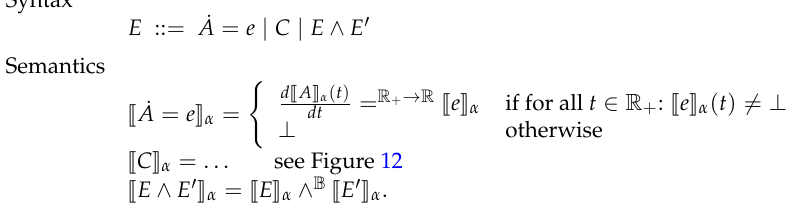
Figure 13. Systems of constrained equations with O DE s.